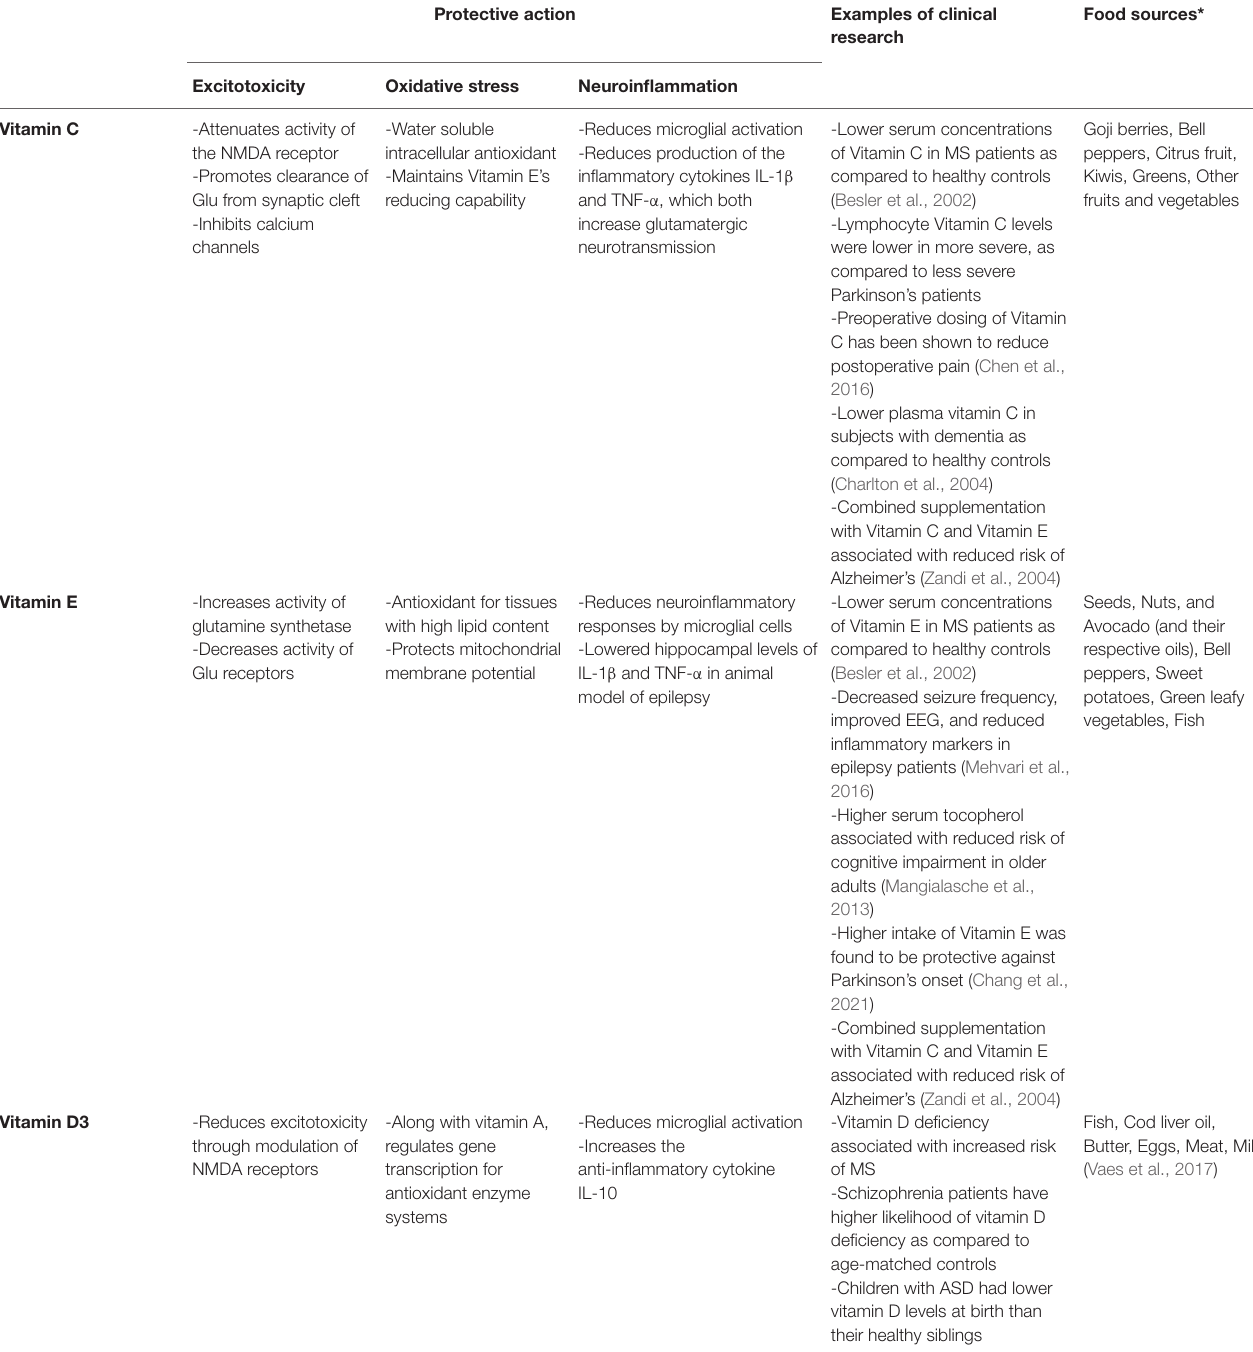
TABLE 1 | Micronutrients which protect against excitotoxicity, oxidative stress, and/or